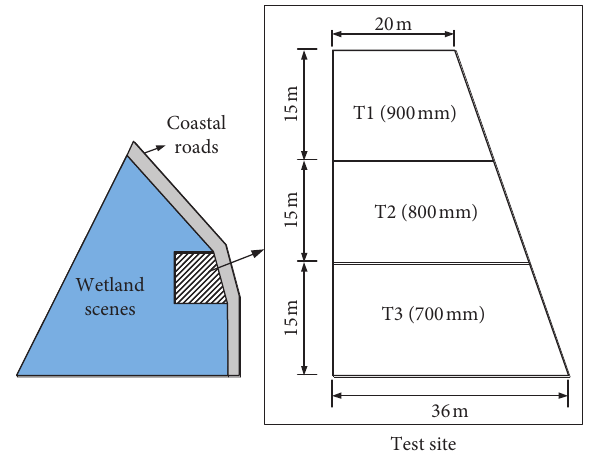
Figure 2: Location of test